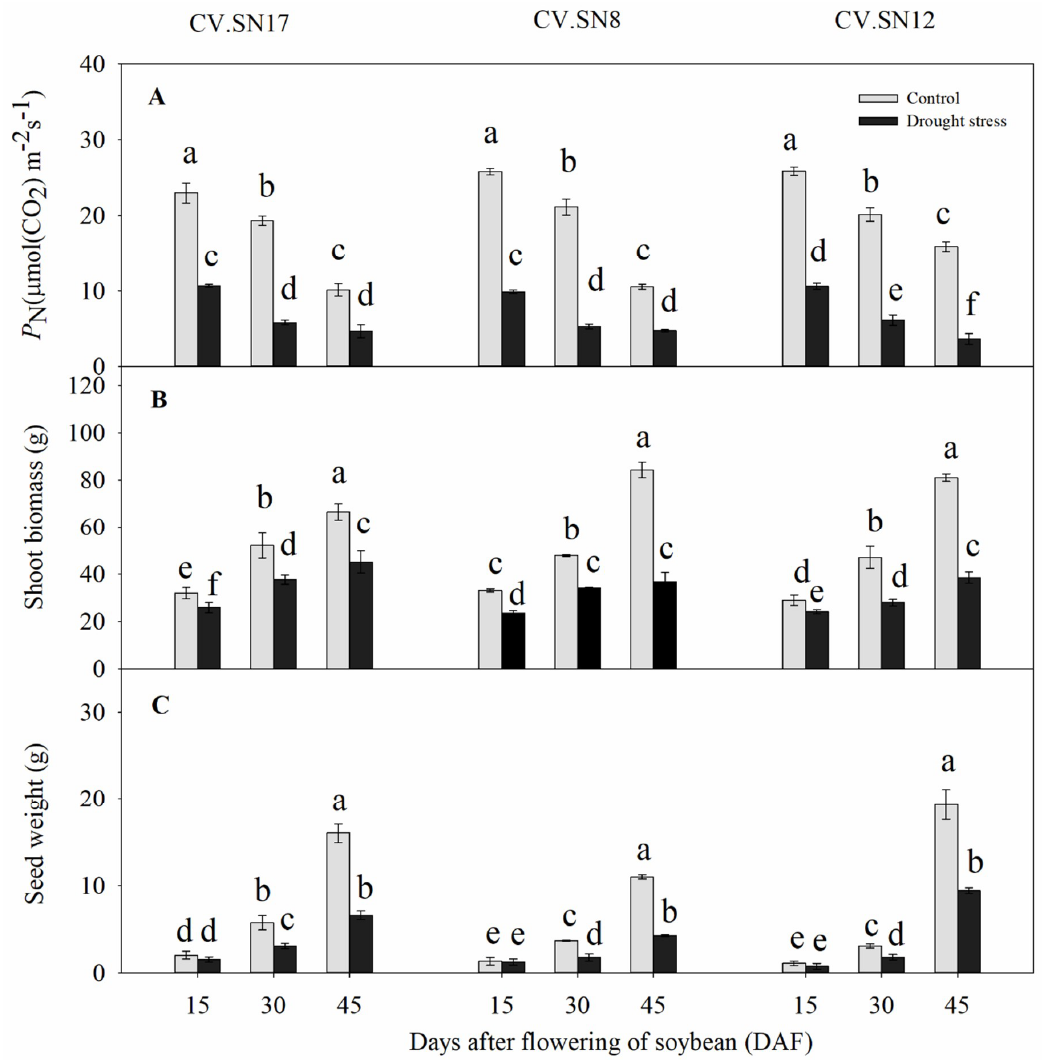
Figure 1. Effect of drought stress on photosynthesis rate, shoot biomass, and seed weight in different soybean cultivars. ( A ) The photosynthesis rates, ( B ) shoot biomass totals, and ( C ) seed weights of “Shennong17” (CV.SN17), “Shennong8” (CV.SN8), and “Shennong12” (CV.SN12). Standard deviations were calculated with three independent experiments each comprising two soybean plants. Different letters above vertical bars indicate significant differences between means at a p < 0.05 level.